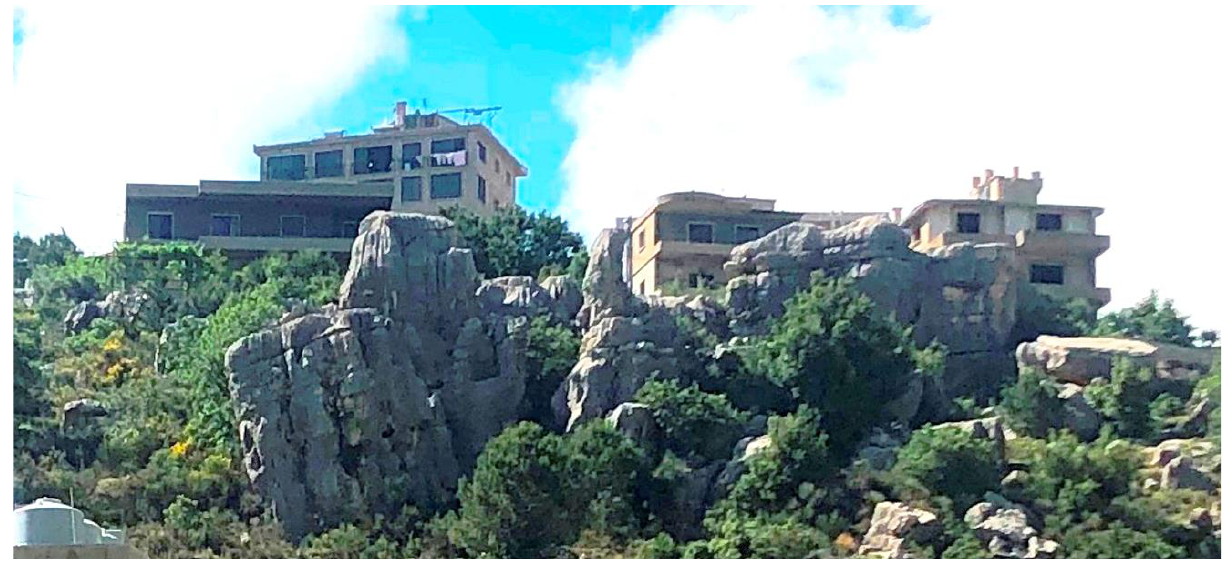
Figure 3. Construction built on rockfalls.